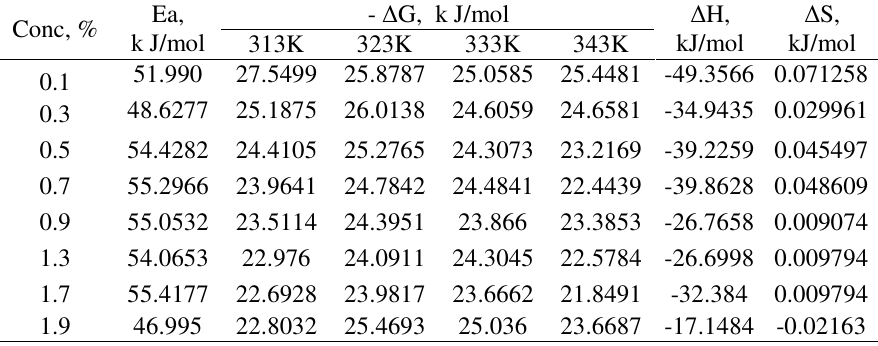
Table 3. Thermodynamic and kinetic parameters for adsorption of PGA on MS